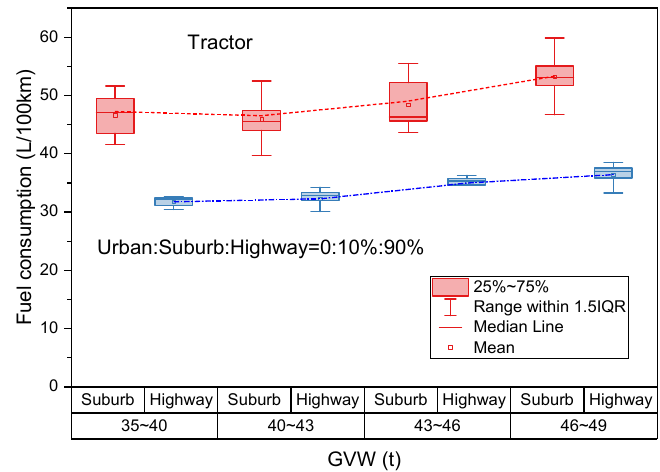
Figure 15. Fuel consumption of different cycle parts (tractor).